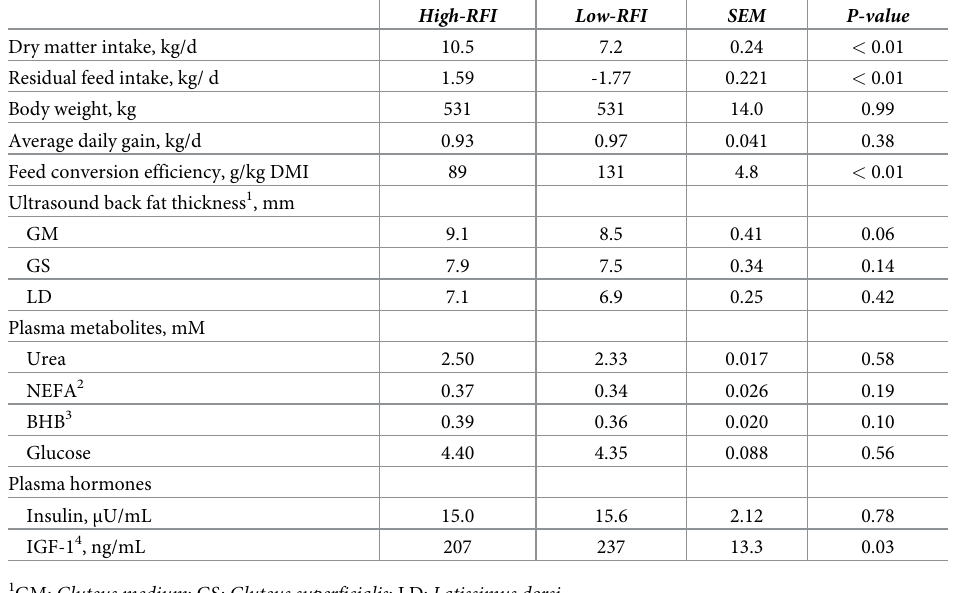
Table 2. Animal performance and classical plasma blood metabolites across Low vs. High residual feed intake (RFI) heifers. Data is presented as least square means and standard error of the mean